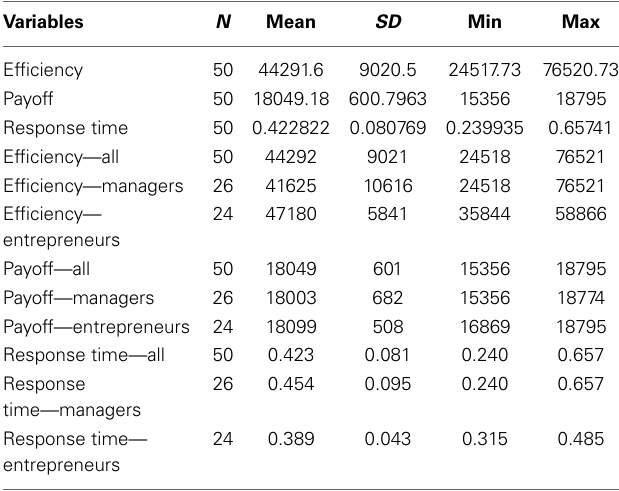
Table 2 | Different measures of behavioral performance (efficiency, payoff, and